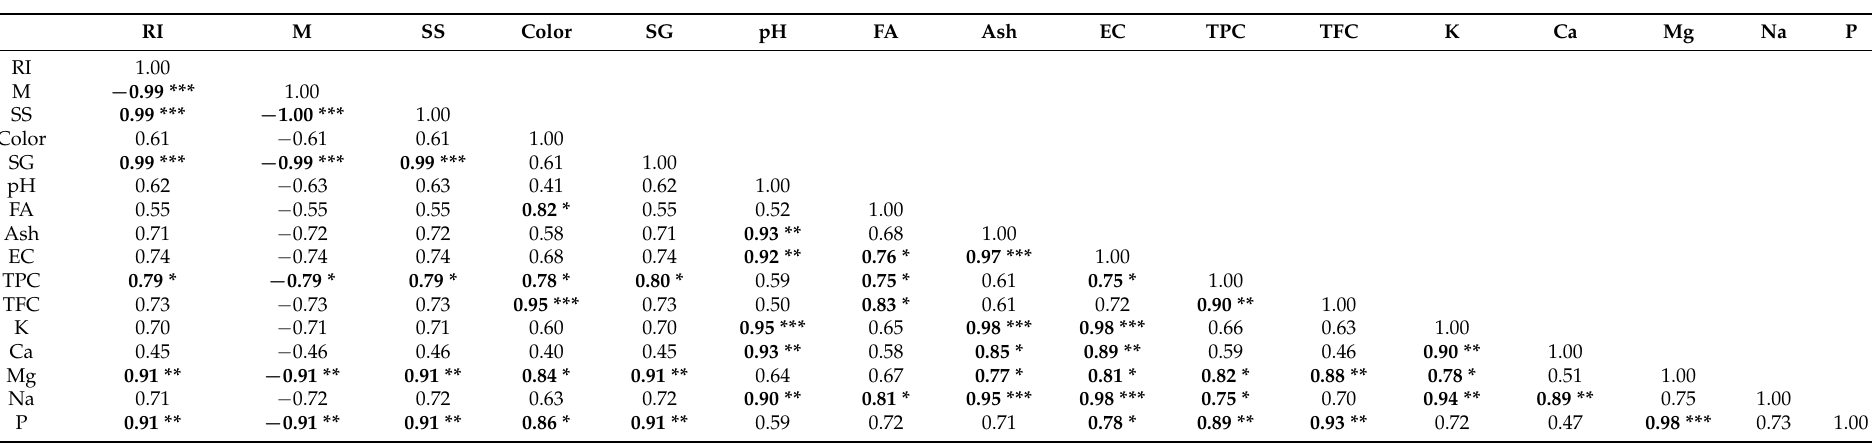
Table 7. Pearson’s correlation coefficients between the investigated honey parameters (significant at: p < 0.05 (*), p < 0.01 (**), p < 0.001 (***)). The values of significant correlation coefficients are marked in